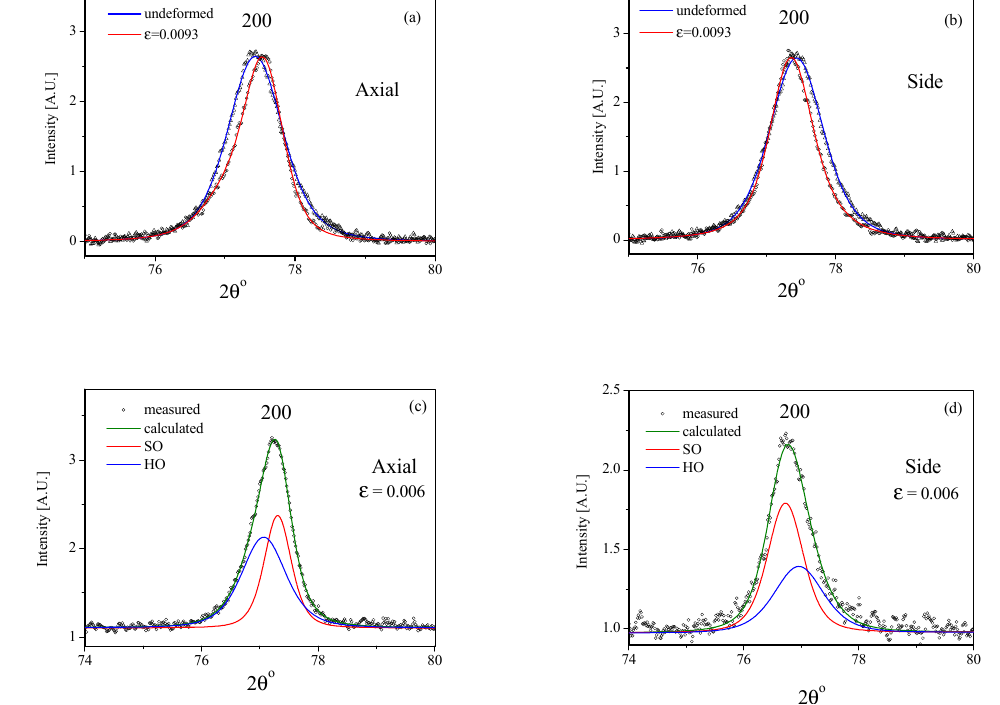
Figure 6. Enlarged 200 diffraction profiles: the measured and CMWP-calculated profiles for the undeformed (open triangles and blue lines) and ε = 0.0093 tensile deformed (open circles and red lines) states corresponding to the axial ( a ) and side ( b ) surfaces. The measured (open circles), the CMWP-calculated total- (green lines) and sub-profiles corresponding to the HO (blue lines) and SO (red lines) packets for the ε = 0.006 tensile deformed states in the axial ( c ) and side ( d ) directions.